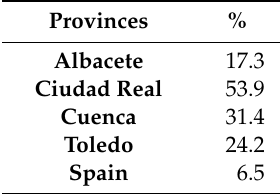
Table 6. Contribution in Castilla-La Mancha of wine to the increase of the blue water footprint of crop production (1955–2010)